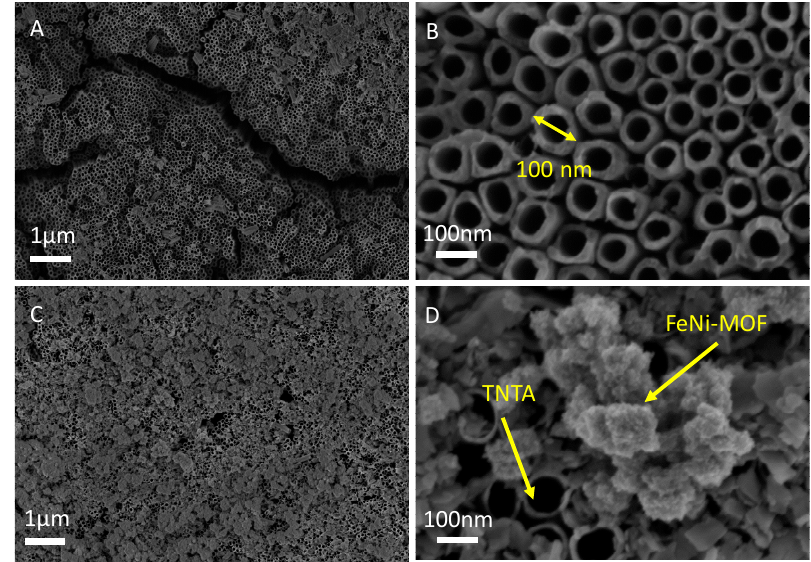
Figure 1. SEM image of ( A , B ) anodized TiO 2 nanotube arrays (TNTA) and ( C , D ) nickel and iron bimetallic organic framework (FeNi-MOF/TNTA) (0.03M_Fe/0.01M_Ni) with different magnifications.